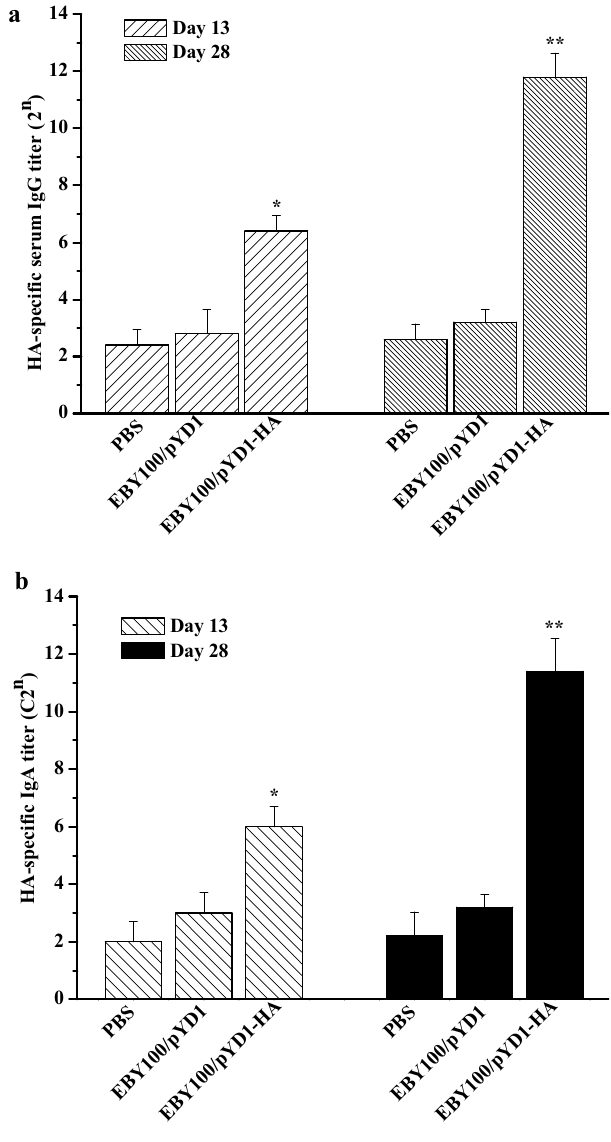
Figure 2. Antibody responses elicited by oral administration of EBY/pYD1-HA. ( a ) HA-specific IgG titer in the serum. ( b ) Secretory mucosal IgA titer in the small intestine washes. Asterisks represent statistically significant differences compare with the PBS- and EBY100/pYD1 controls. * p ˂ 0.05, ** p ˂